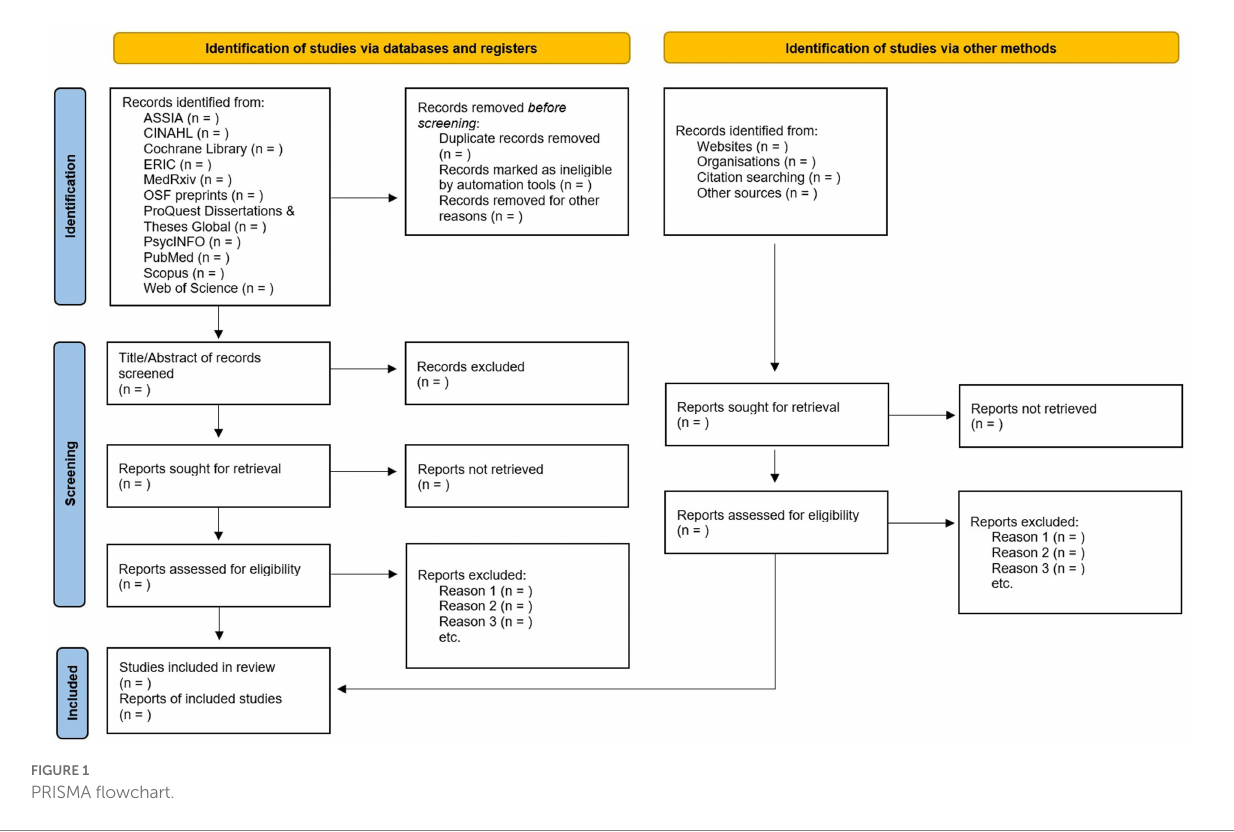
FIGURE 1 PRISMA flowchart.